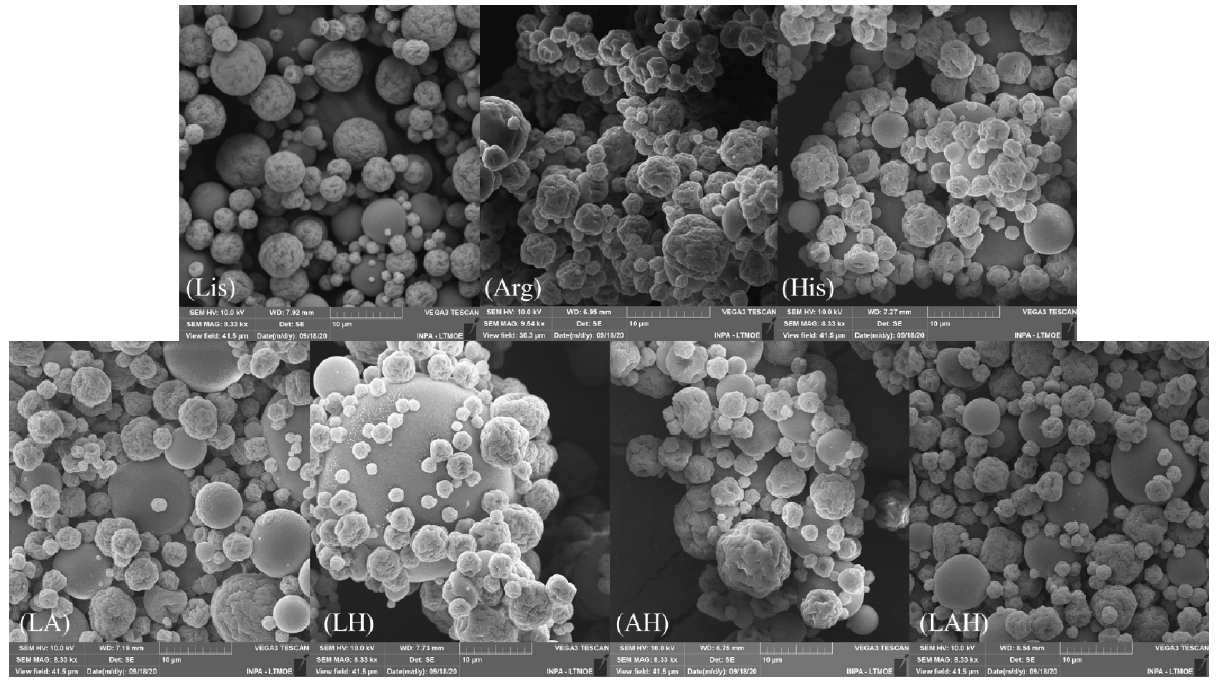
Figure 7. SEM images of the developed systems.